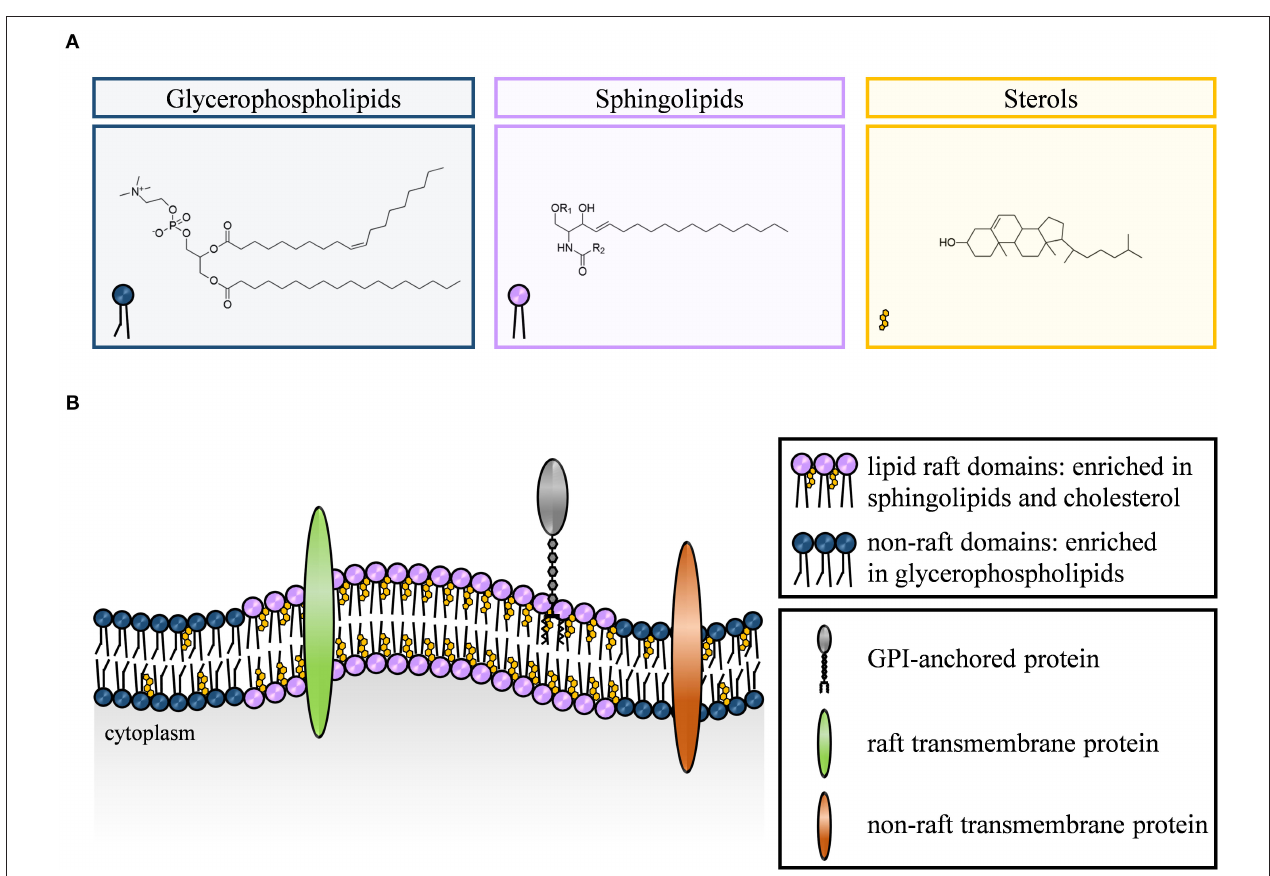
FIGURE 1 | Chemical structure of main lipid classes and composition of cell membranes. The mammalian plasma membrane consists of three lipid classes, namely glycerophospholipids (depicted in blue), sphingolipids (purple), and sterols (yellow) (A) . Functionally, the cellular membrane is a lipid bilayer forming both, lipid raft and non-raft domains. Lipid rafts are enriched in sphingolipids, cholesterol, glycosylphosphatidylinositol (GPI)-anchored proteins and some transmembrane proteins, whereas non-raft domains are composed predominantly of glycerophospholipids and non-raft transmembrane proteins (B)